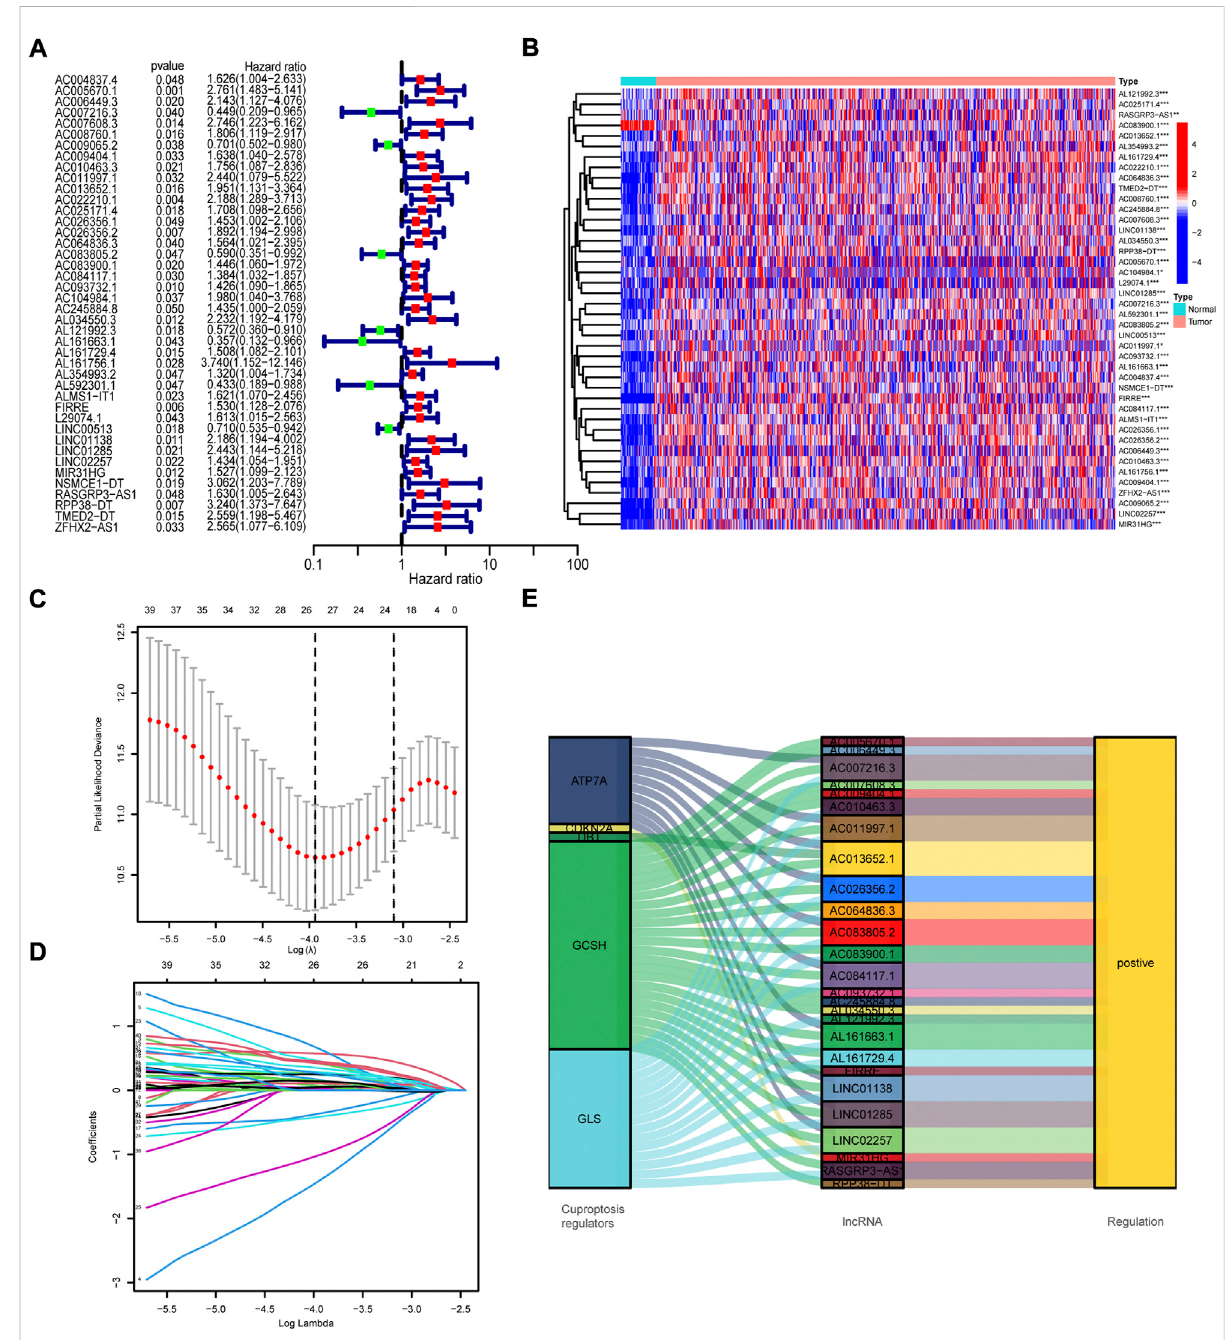
FIGURE 2 Screen of cuproptosis-related lncRNAs. (A) The results of univariate Cox regression analysis of prognosis-related lncRNAs. (B) The expression pro fi les of 42 prognosis-related lncRNAs. (C) The cross-validation in the LASSO model. (D) LASSO coef fi cient pro fi le of prognosis-related lncRNAs. (E) Sankey diagram of cuproptosis regulators and prognosis-related